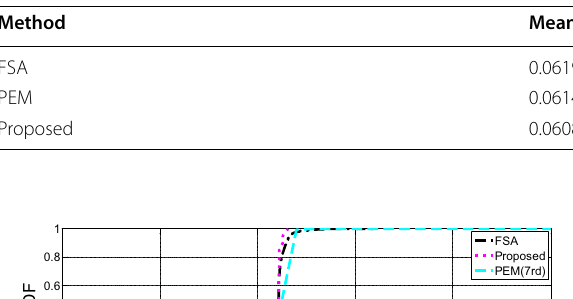
Table 9 Means and standard deviations of loss (MW)